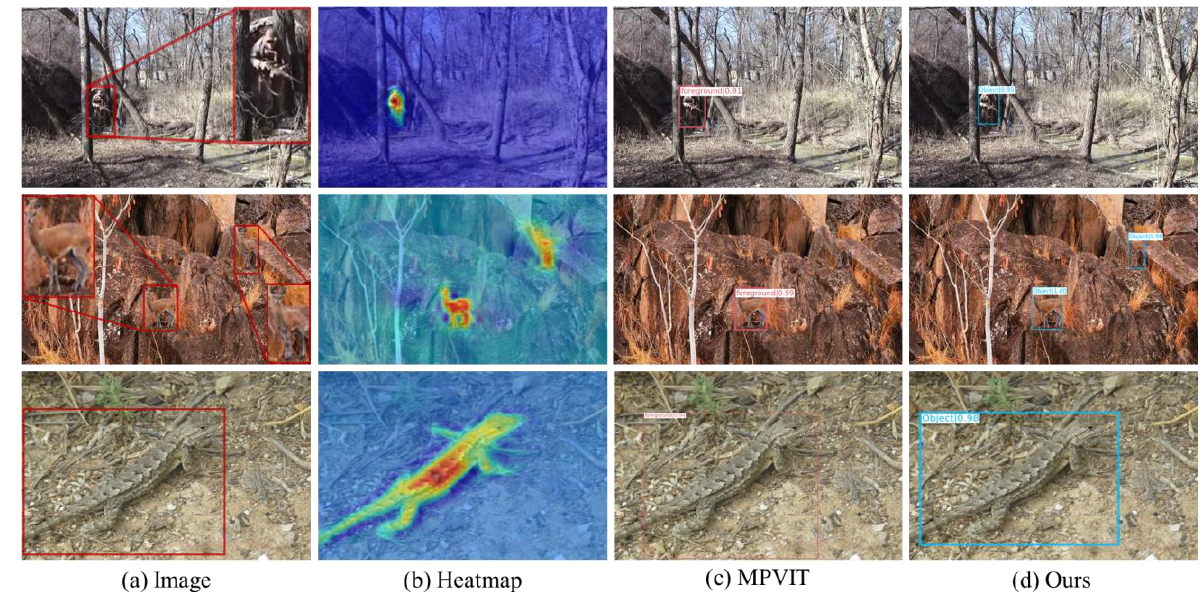
Figure 1. Examples of camouflaged object detection (COD).